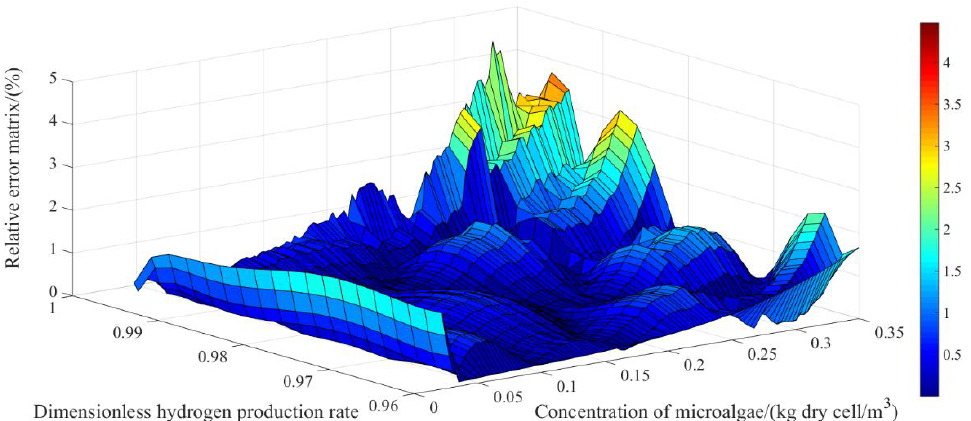
Figure A5. The relative error matrix about Figure 9a.